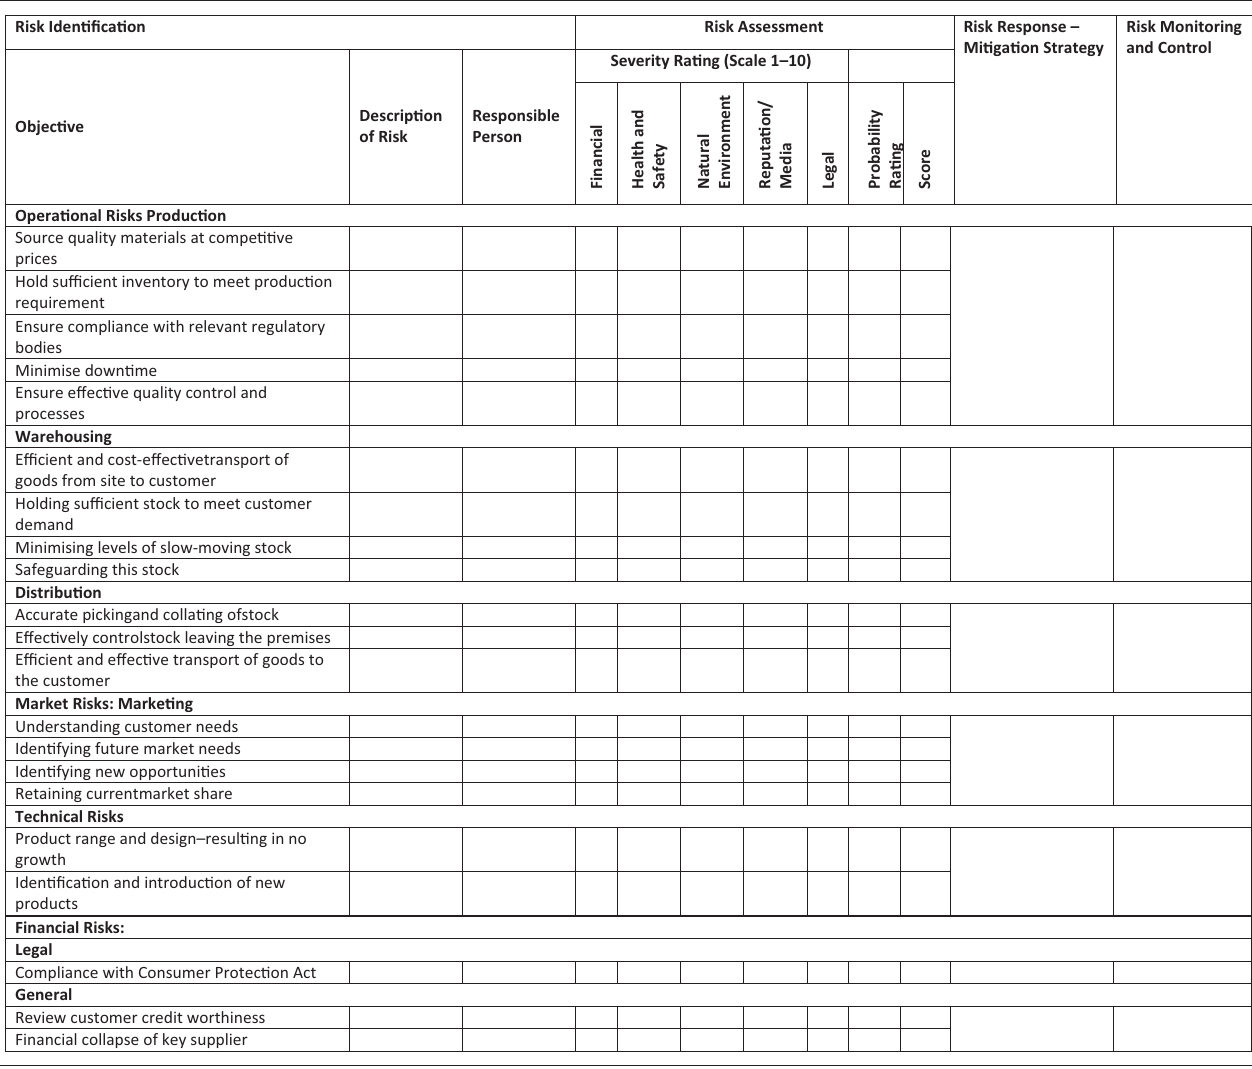
FIGURE 2: Operational risk management